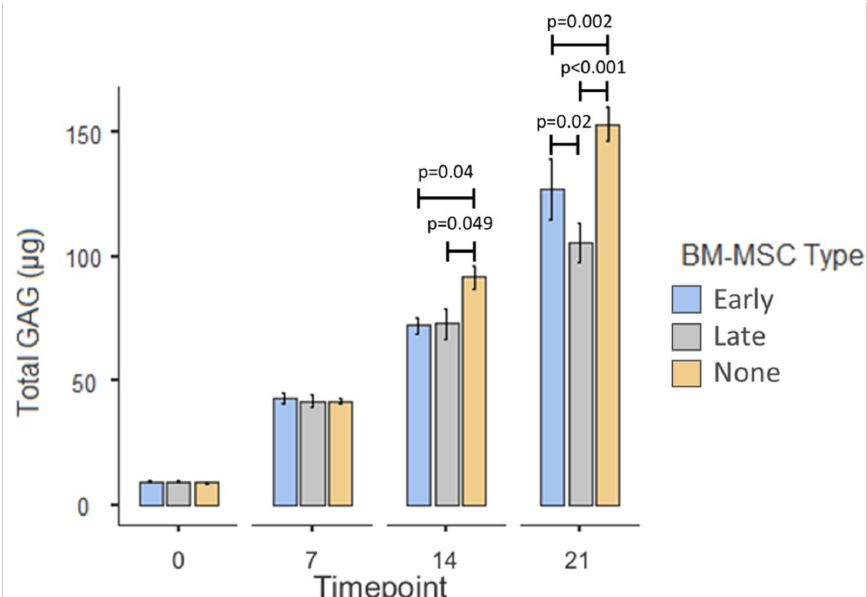
Figure 9. Mean total GAG content of agarose scaffolds taken from the co-culture model at the four timepoints. Error bars represent the standard error of the mean. Significant differences are indicated by horizontal